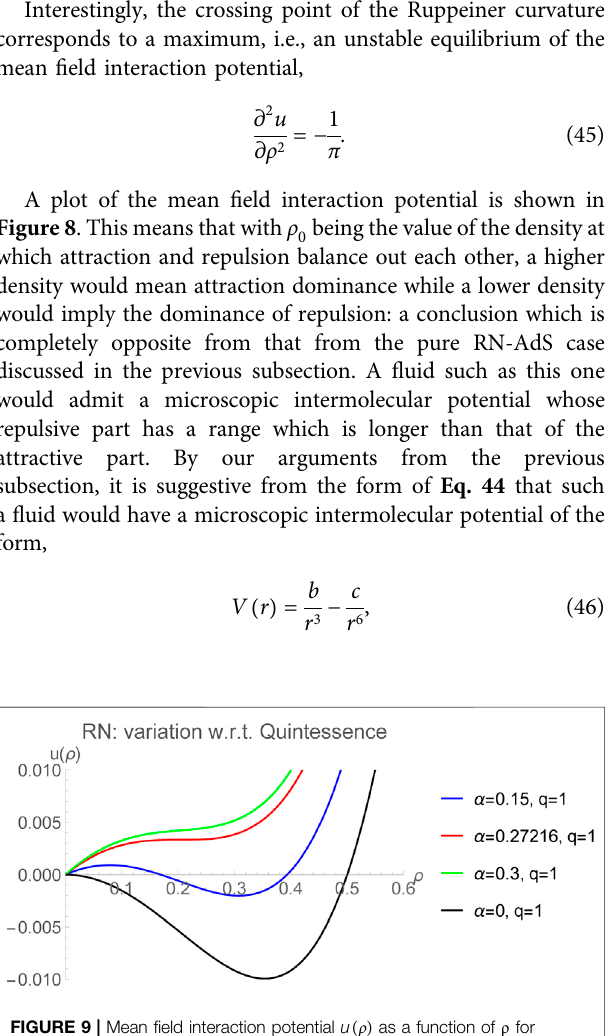
FIGURE 9 | Mean fi eld interaction potential u ( ρ ) as a function of ρ for various values of α with q (cid:2)